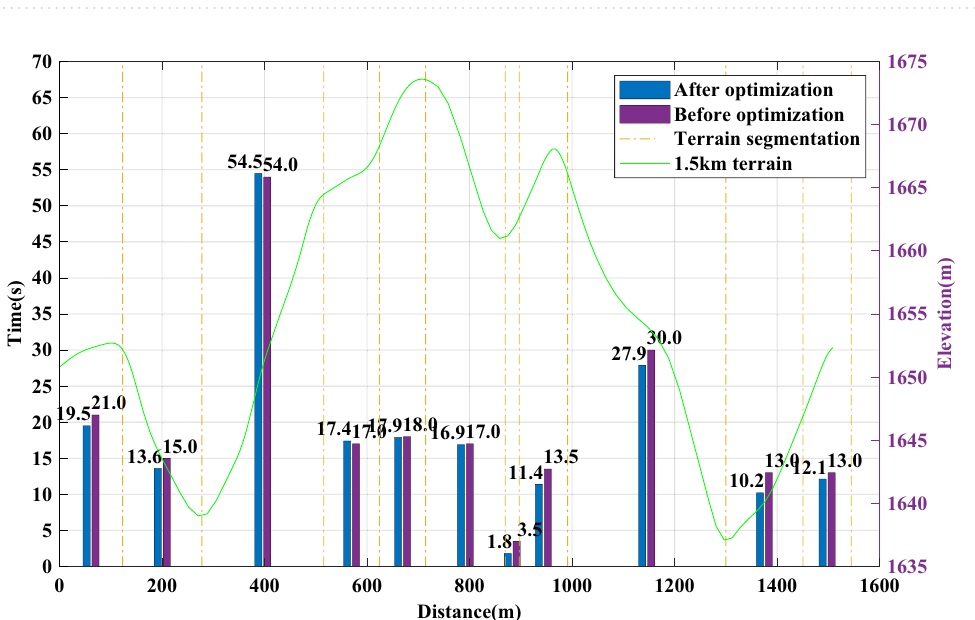
Figure 9. Time distribution of athlete A before and after